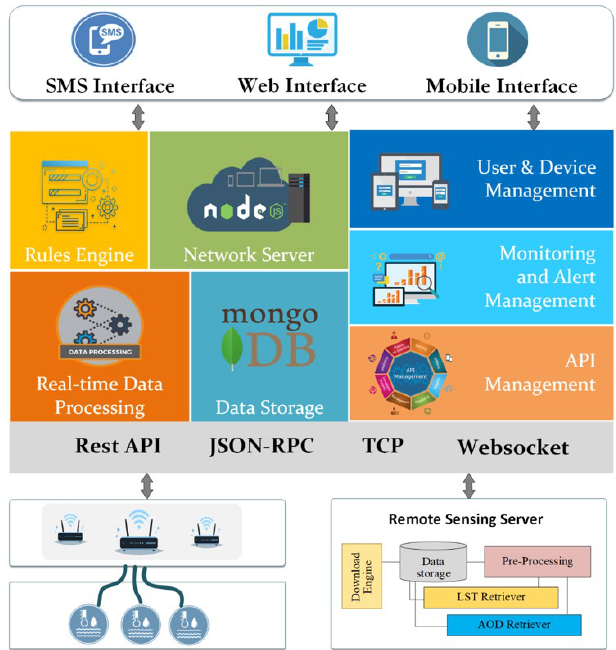
Figure 7. The architecture of the cloud